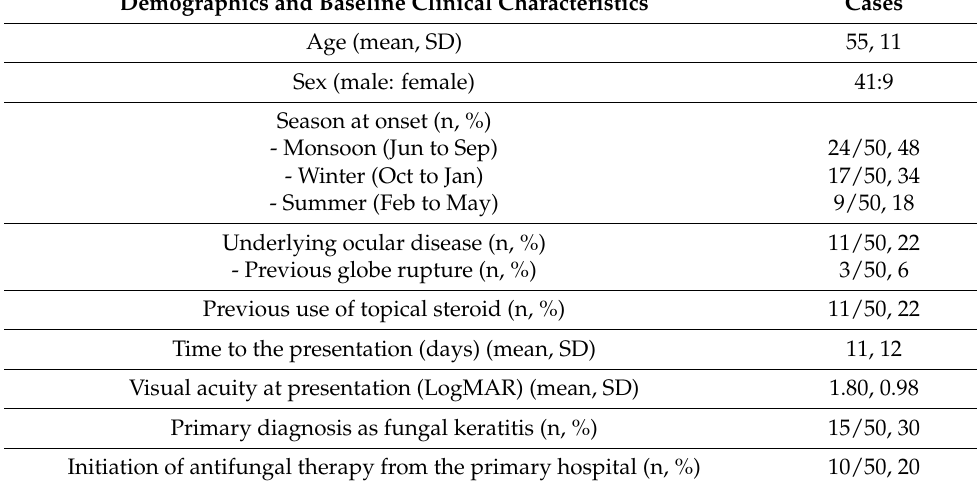
Table 1. Demographics and baseline clinical characteristics of patients with dematiaceous fungal keratitis ( N = 50).